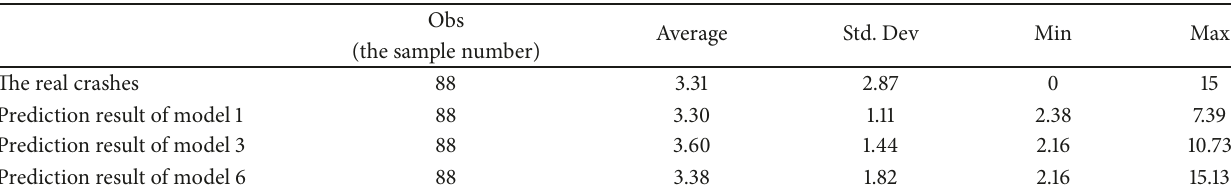
Table 6: Statistics values of predicted and real